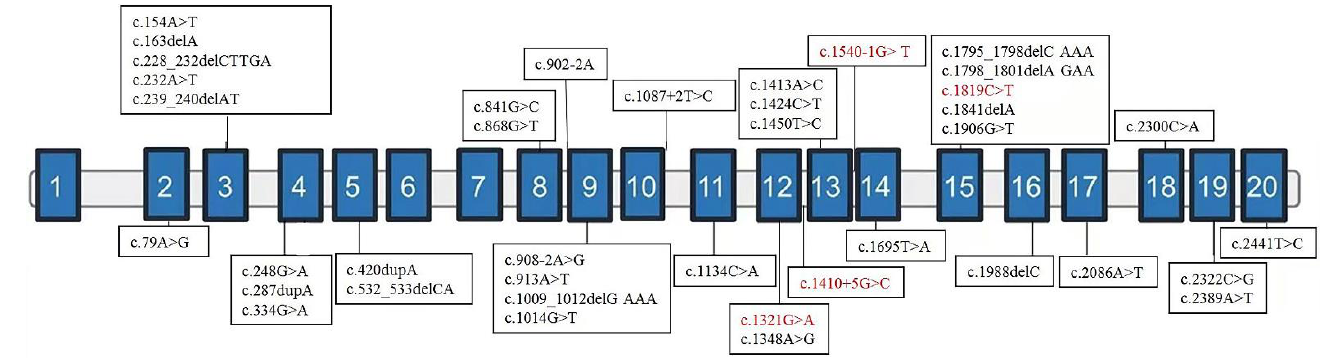
Figure 2. Exonic localization of NAA15 variants. Schematic representation of the genomic structure of human NAA15 and variants identified in this study (in red) and those previously reported elsewhere (in black). Solid rectangles indicate exons, and the horizontal bars represent introns.